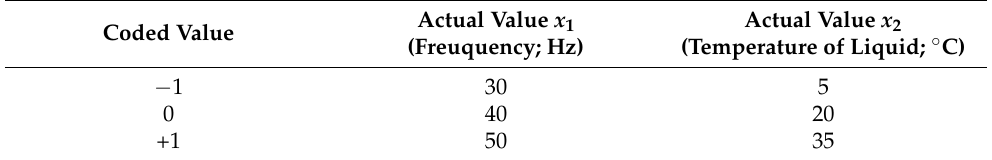
Table 2. The values and codes of the different dissolution test